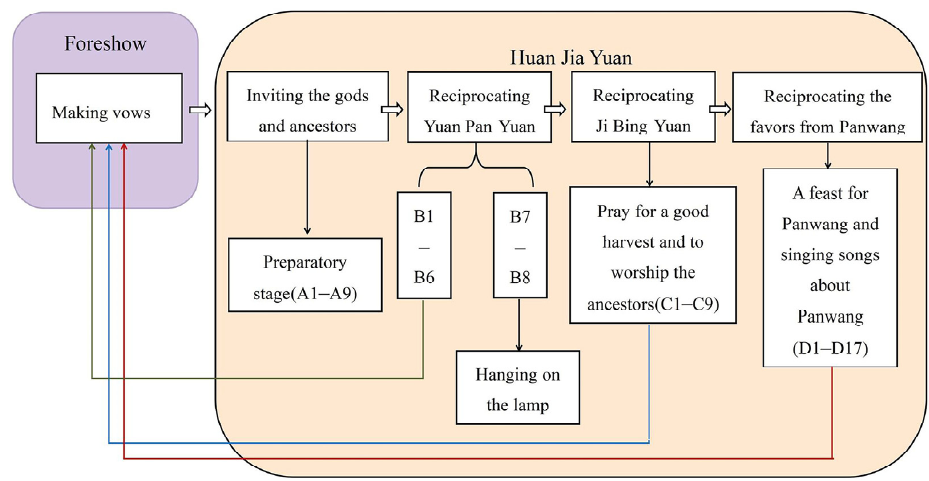
Figure 11. The process structure of the Yao Huan Jia Yuan ritual in Huangdong Township .